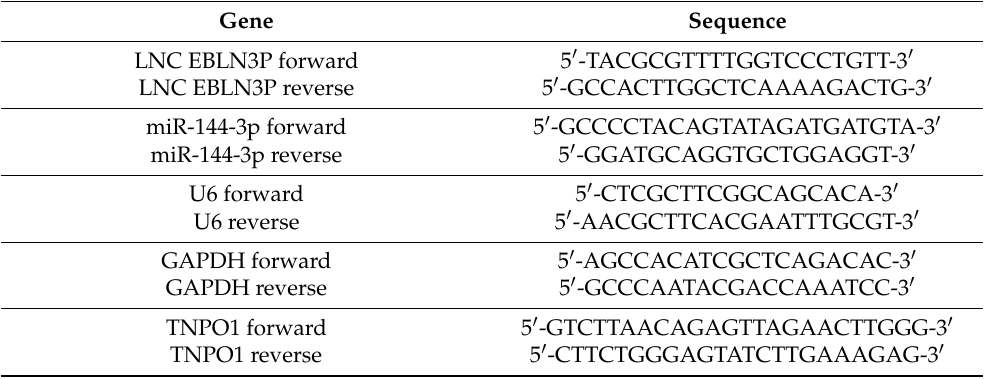
Table 2. Oligonucleotide primer sequences used for